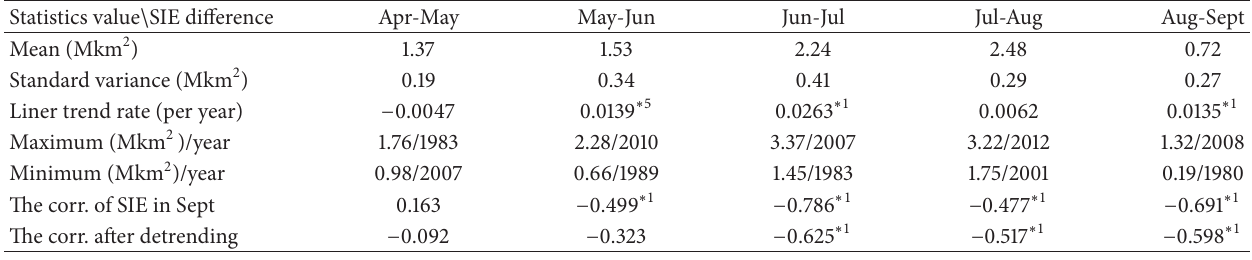
Table 1: Statistical analyses of the five sea ice extent (SIE) differences (unit: millions of square kilometers (Mkm 2 )) for April minus May (AM), May minus June (MJ), June minus July (JJ), July minus August (JA), and August minus September (AS) during 1979–2012 and the correlation between September SIE and these five SIE differences. Trends significant at 95% and 99% confidence level are indicated with asterisks as ( ∗ 5) and ( ∗ 1); correlation coefficients higher than 0.339 and 0.435 are defined as at 95% ( ∗ 5) and 99% ( ∗ 1) confidence levels, respectively.